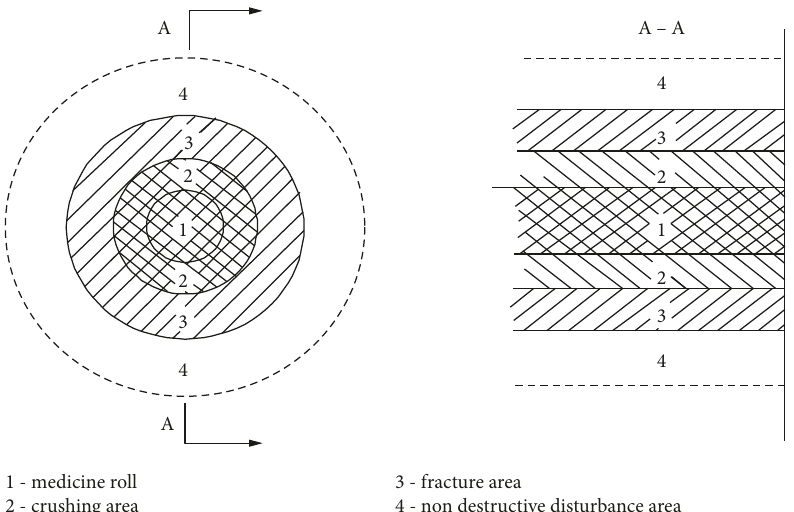
Figure 13: Borehole division of pressure relief blasting in coal seam.